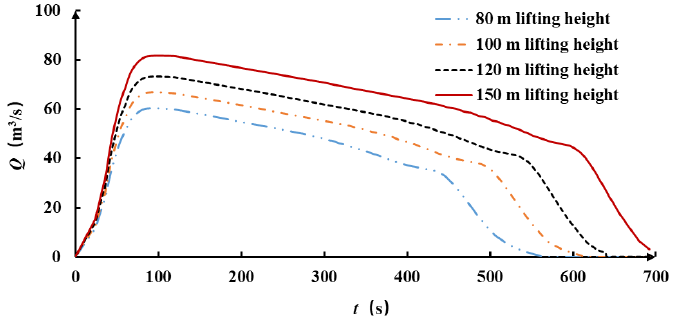
Figure 8. The change process of the filling water flow in the filling–emptying system under the condition of 80 m, 100 m, 120 m and 150 m lifting heights.